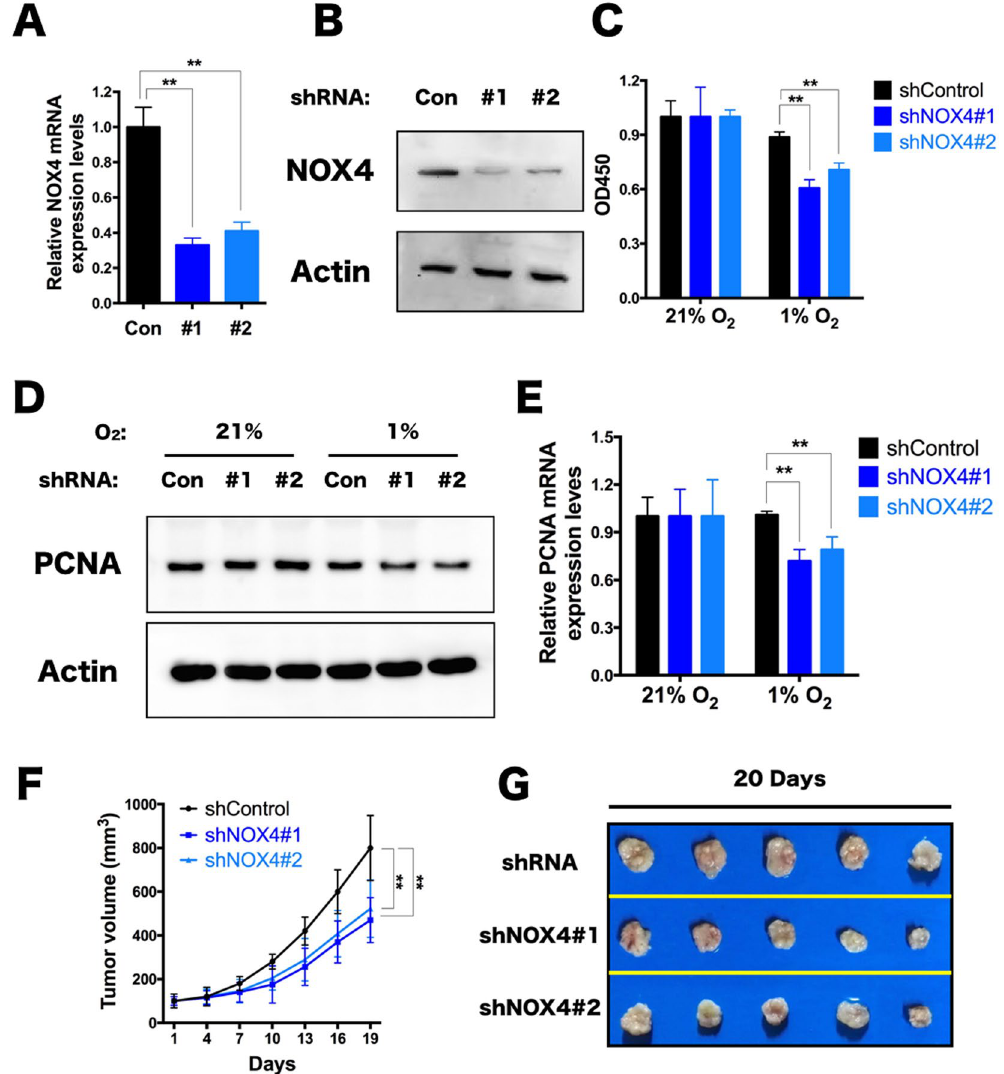
Figure 1. NOX4 Knockdown results in inhibition of TPC-1 Proliferation. ( A,B ) Transcriptional expression of NOX4 in TPC-1 cells after 48 hours treated with lentiviral transduction particles targeting NOX4 mRNA ( A ). Protein expression level of NOX4 after 72 hours treated with lentiviral transduction particles targeting NOX4 mRNA ( B ). Con for shNOX4 control lentivirus, #1 for shNOX4#1 lentivirus, and #2 for shNOX4#2 lentivirus. ** P < 0.01. ( C) Viability assay for TPC-1 cells expressing shControl or shRNA against NOX4 (shNOX4#1,#2) which were cultured in normoxia (21% O 2 ) and hypoxia (1% O 2 ) respectively for 48 hours using CCK8 assay (n = 8). ** P < 0.01. ( D,E) Western blot for normoxia (21% O 2 ) and hypoxia (1% O 2 ) in TPC-1 cell clones